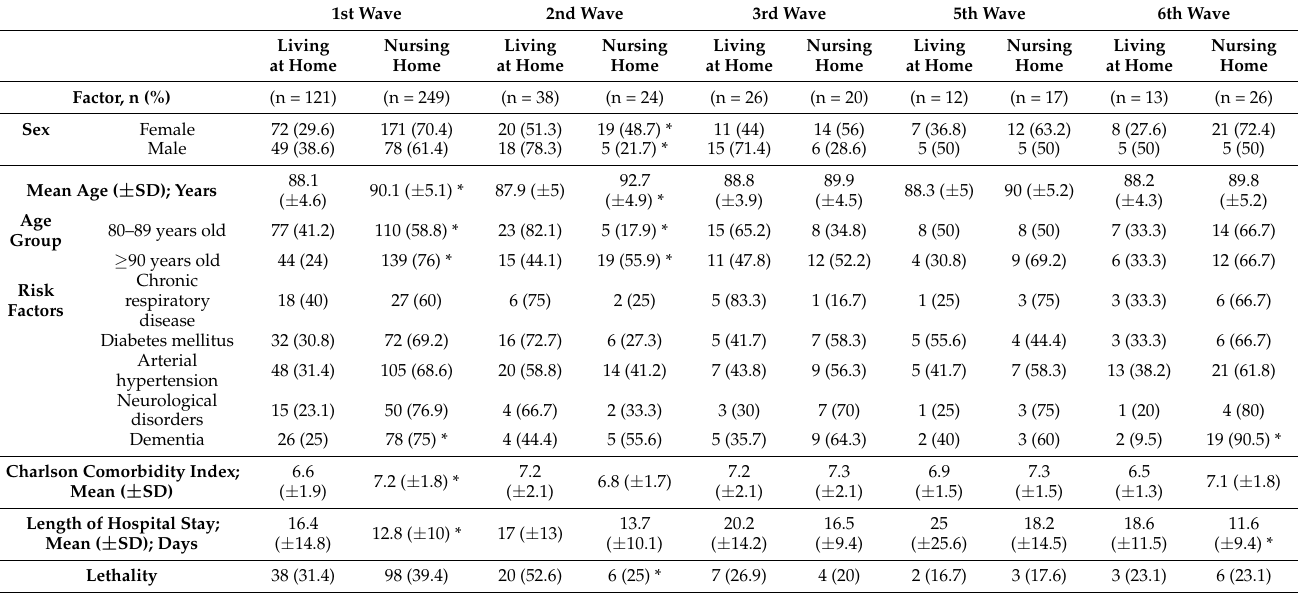
Table 2. Clinical and sociodemographic factors of patients infected by SARS-CoV-2, differences according to living arrangement and COVID-19 pandemic waves in